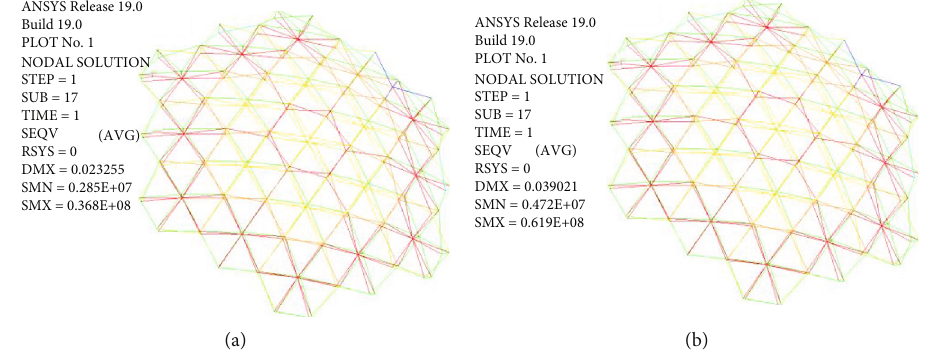
Figure 6: Thermal stress distribution. (a) t